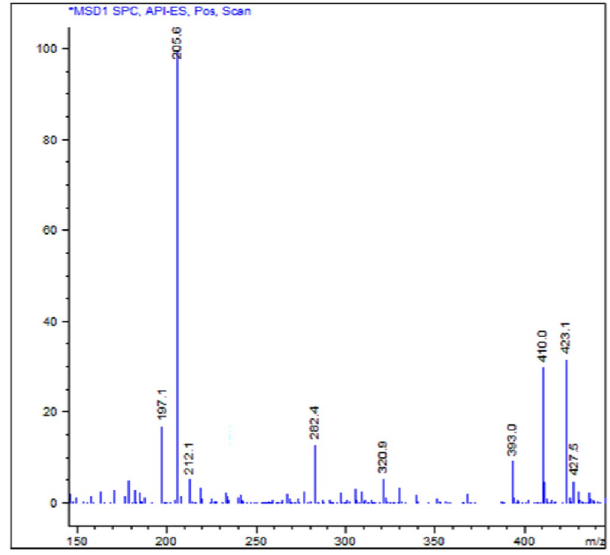
Figure 2. Mass spectrum obtained by direct injection of a sample of the mixture. Conditions described in “Methods - General chemistry ”.